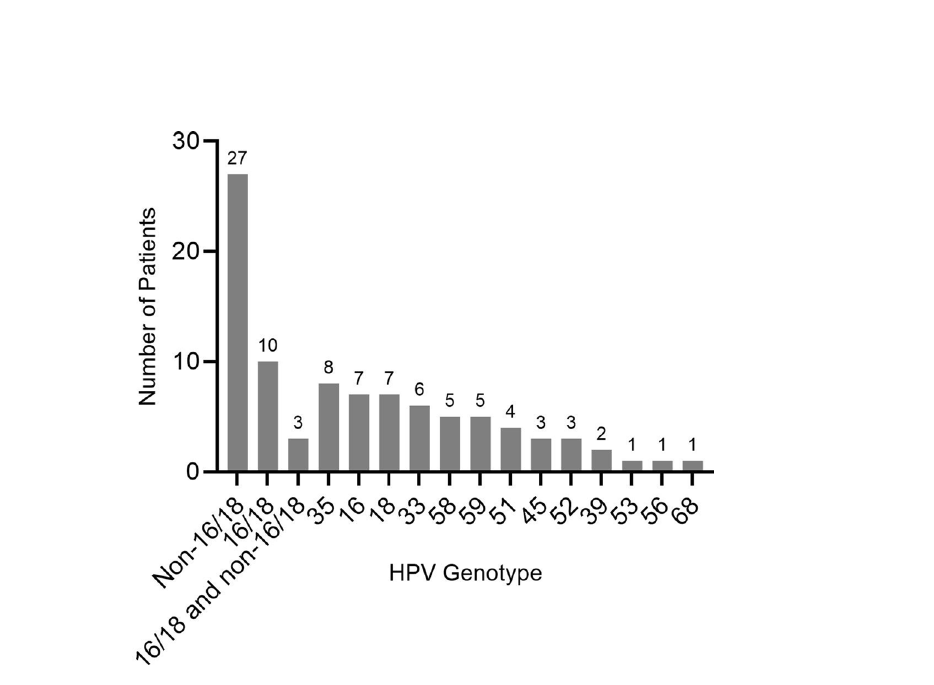
Figure 3. Frequency of HPV types isolated from squamous cell carcinoma of the